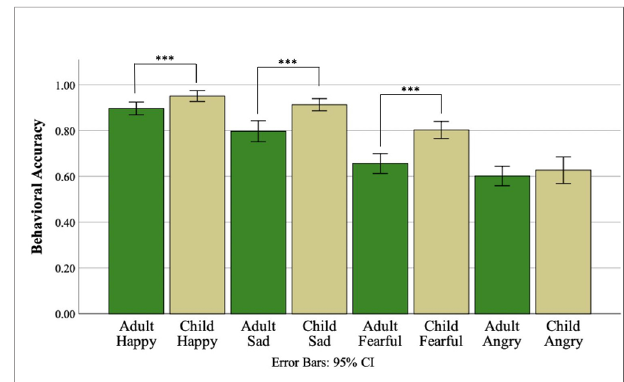
FIGURE 3 | Percent FER accuracy for the adult and child subtests of the DANVA-2 by emotion. *** p